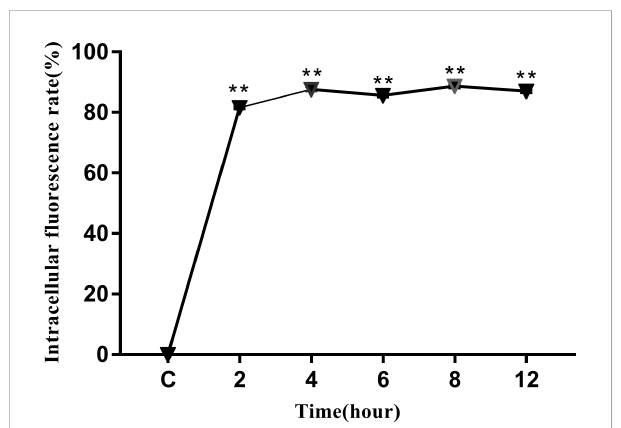
FIGURE 6 Release levels of reactive oxygen species at different time periods. The ROS release assay was repeated three times, and each experiment was performed in triplicate. Results are presented as mean ± SD. * P <0.05, compared with the control group.